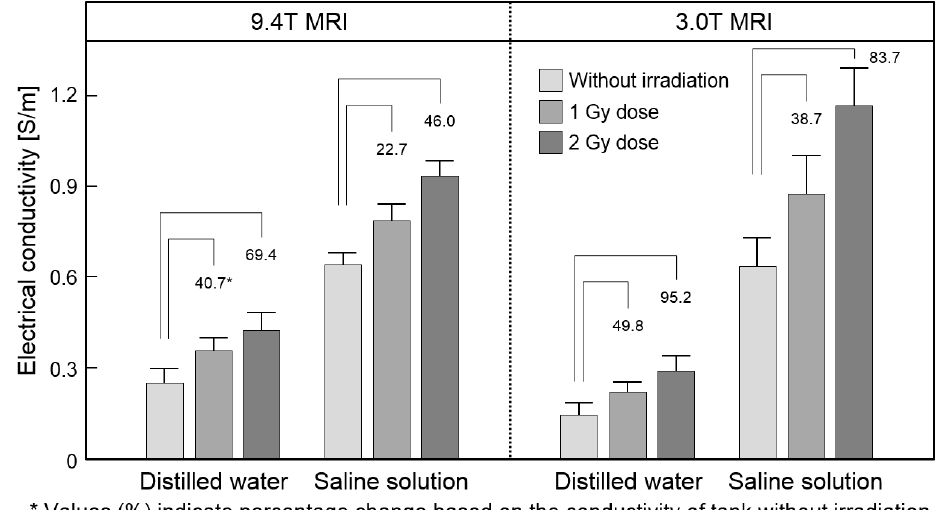
Figure 3. Analysis of phantom conductivity images obtained from 9.4T and 3T MRI. Absolute conductivity and relative conductivity change were obtained from the two solutions by different irradiation doses. Table 1. Summary of electrical conductivity and relative conductivity change in phantom imaging. The measured con- ductivity indicates absolute values by irradiation dose. The relative conductivity change indicates the extent of irradiation effects based on the values without irradiation.